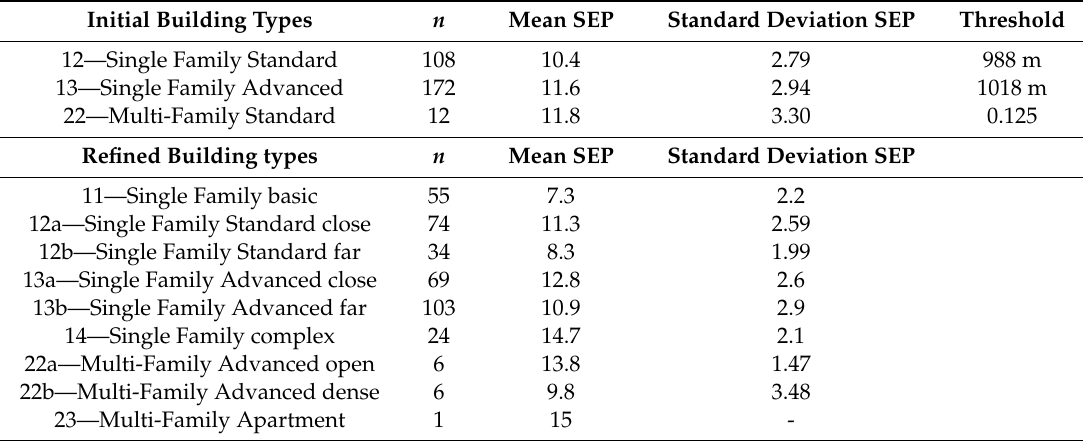
Table A2. Overview on thresholds for building type disaggregation and socio-economic statistics on refined building types. Thresholds for building type disaggregation apply to BT12: distance to market center, BT13: distance to US embassy, BT22: share of built-up area within a 250 m